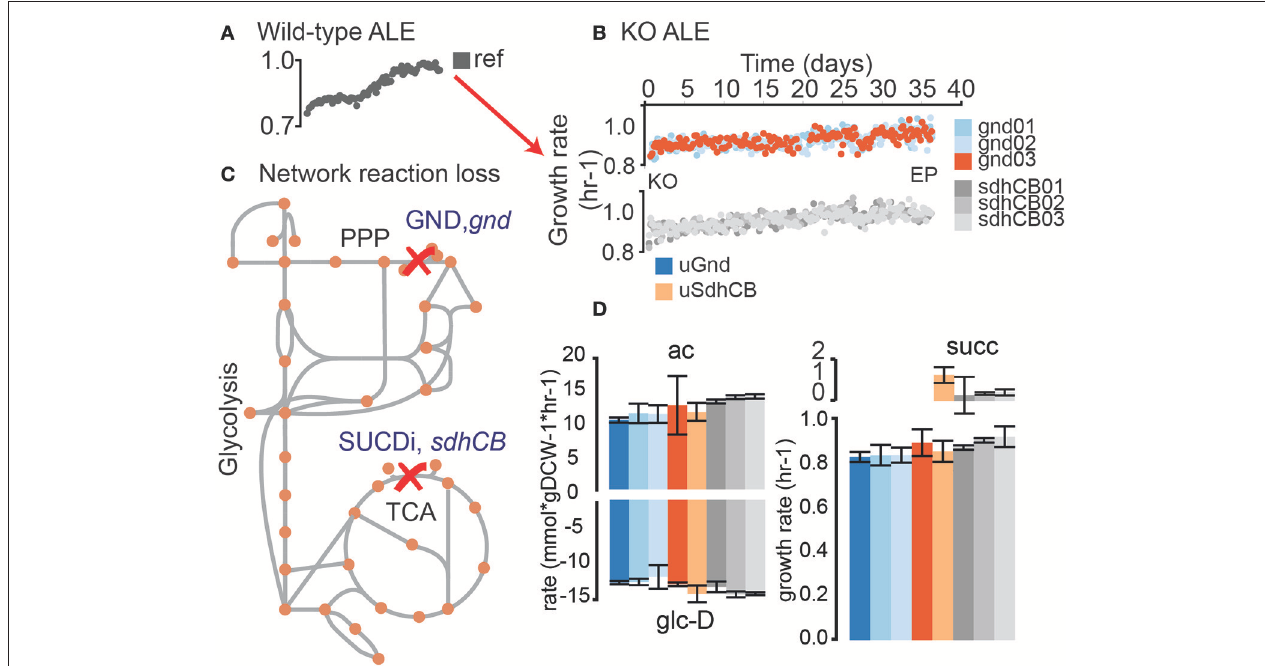
FIGURE 1 | Evolution of knockout (KO) strains from a pre-evolved (i.e., optimized) wild-type strain. (A) Wild-type (wt) E. coli (MG1655 K-12) was previously evolved on glucose minimal media at 37 ◦ C (LaCroix et al., 2015). An isolate from the endpoint of the evolutionary experiment was selected as the starting strain for subsequent KOs of gnd and sdhCB and adaptive laboratory evolution (ALE). (B) Adaptive laboratory evolution trajectories of the evolved knockout lineages. -Omics data collected included metabolomics, fluxomics, physiology, DNA resequencing, and transcriptomics. (C) 6-phosphogluconate dehydrogenase (GND) and Succinate Dehydrogenase (SUCDi) were disabled by the gene KOs. GND converts 6-phosphogluconate (6pgc) to ribulose 5 phosphate (ru5p-D) in the Pentose Phosphate Pathway (PPP), and SUCDi converts succinate (succ) to fumarate (fum) in the TCA cycle. (D) Growth rate and uptake and secretion rates for unevolved KO (uGnd and uSdhCB) and evolved KOs (eGnd and eSdhCB). The growth rate for uGnd, uSdhCB, eGnd strains, and eSdhCB strains are shown in the plot on the bottom right. Secretion rates for acetate (ac) and succinate (succ) are shown on the top plots. The glucose (glc-D) uptake rates are shown on the bottom left